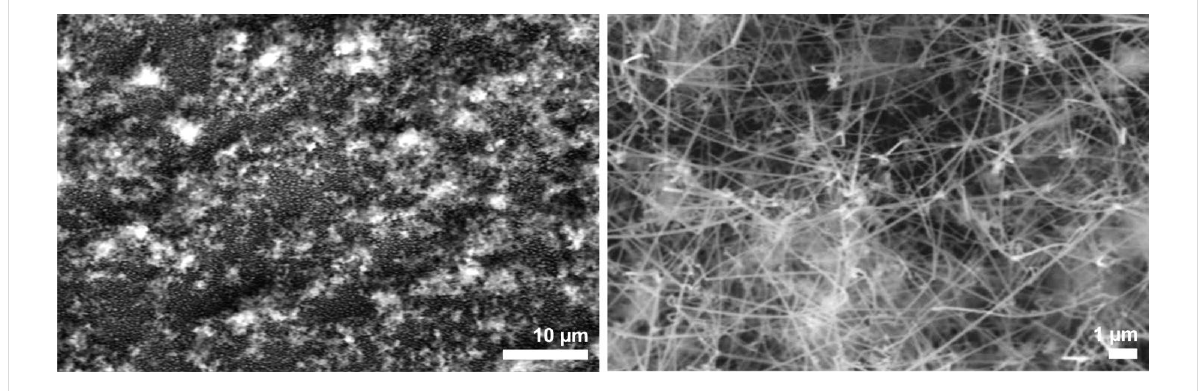
Figure 11: SEM image of Si NWs obtained from spin-coated “liquid bright gold” films after annealing at 650 °C, followed by treatment with NPS at 375 °C (left) and 650 °C (right) for 1 h each.